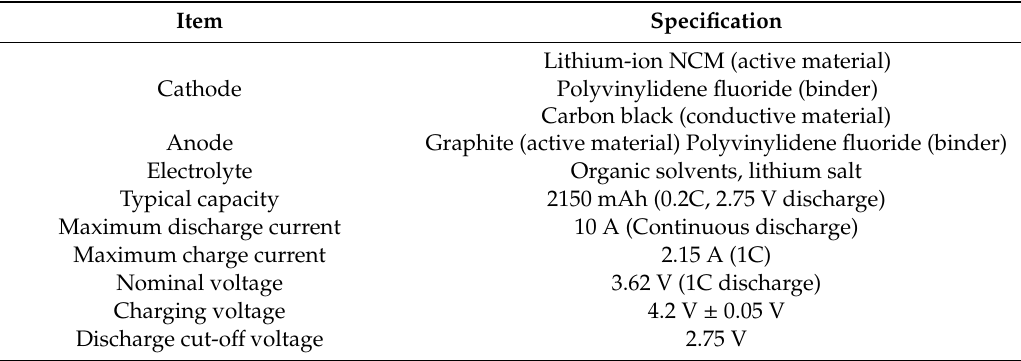
Table 1. The specifications of ICR18650-22P lithium-ion battery.